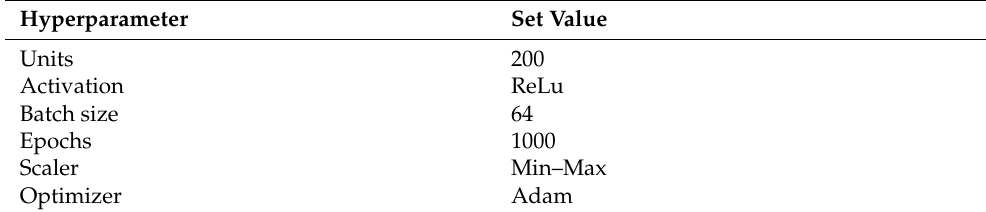
Table 3. Hyperparameters of RNN, GRU, and LSTM used in this